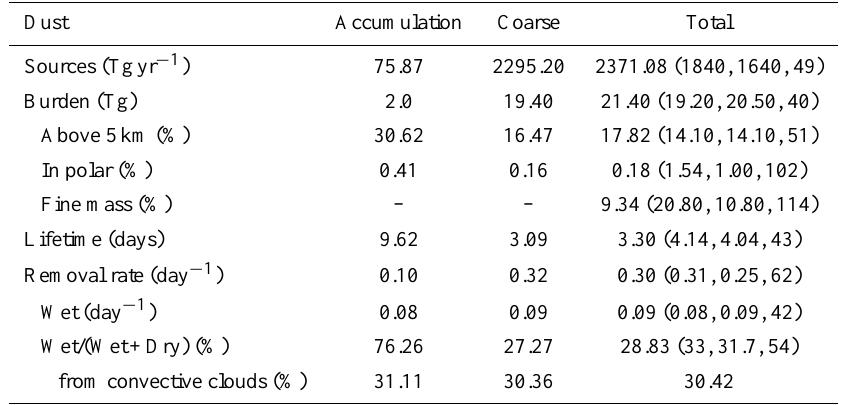
Table 5. Global annual budget for dust. The values in the parenthesis are the mean (left), median value (middle), and standard deviation (right) from available models in AeroCOM (see Textor et al., 2006, Table 10). The standard deviation is normalized by the all models average in the percentage in AeroCOM.